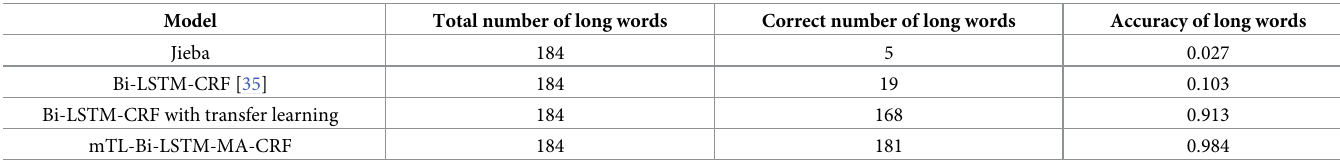
Table 2. Accuracy of long words of